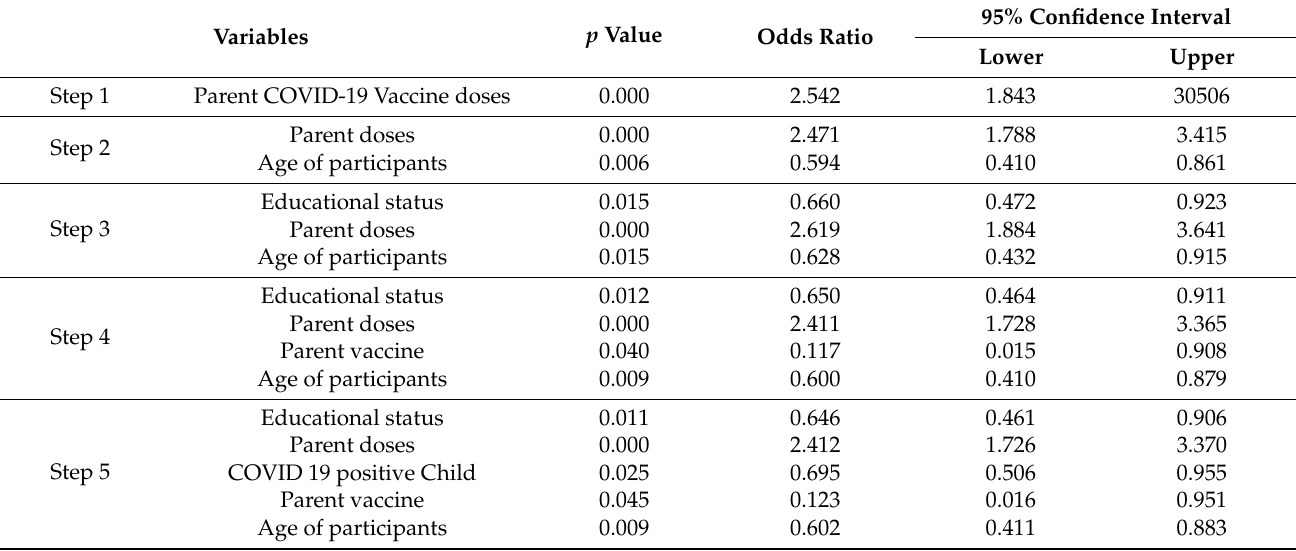
Table 8. Stepwise Linear regression analysis.